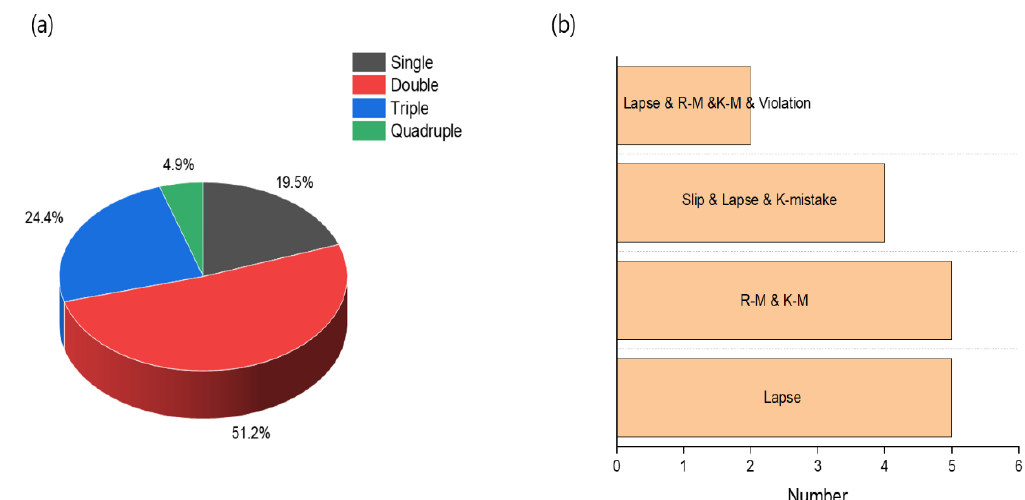
Figure 3. ( a ) Analysis of various factors of human failure and ( b ) analysis of maximum human failure types of single factors and multiple factors .